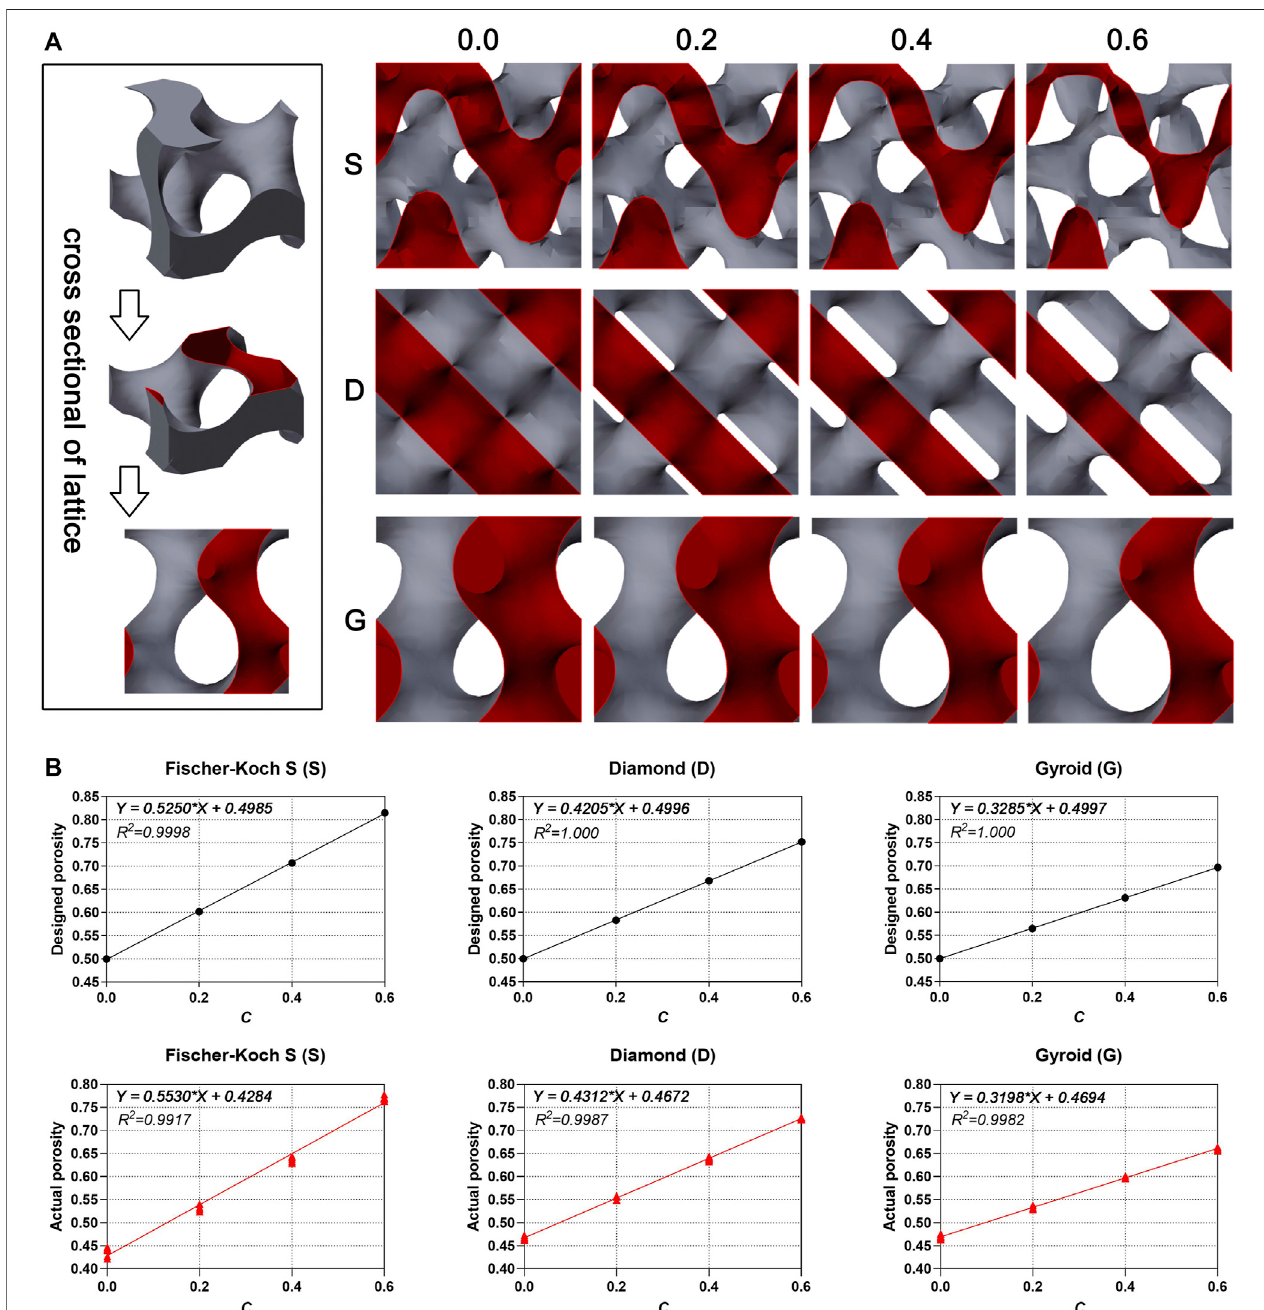
FIGURE 4 | (A) The cross-sectional diagram of single lattice. (B) The linear correlation between designed porosity, actual porosity ( n = 6) and constant